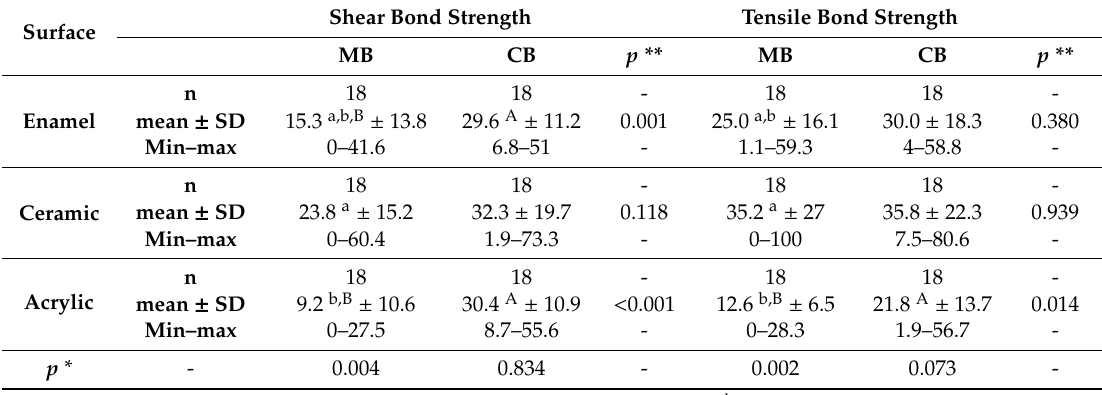
Table 3. Comparison of mean shear or tensile bond strength values (MPa) by a two-way ANOVA, surface and bracket